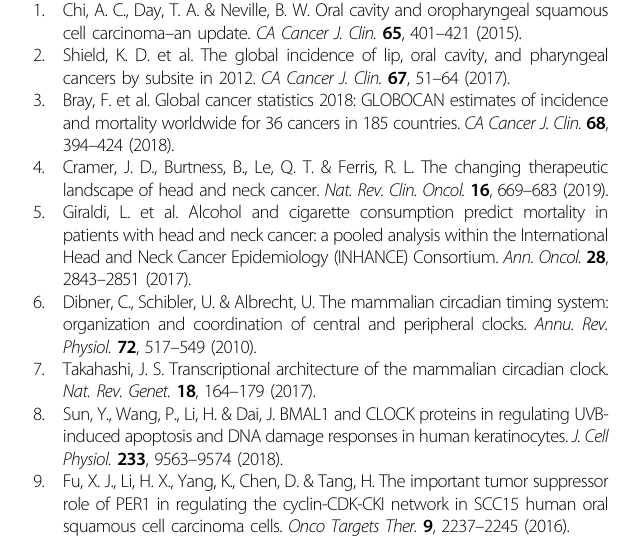
table method, with 5 mice in each group. OE-PER1- SCC15 and NC-SCC15 cell suspensions (0.2 ml) at a concentration of 5 × 10 6 cells/ml were injected sub- cutaneously into the left dorsal region of nude mice in the experimental group and the control group,